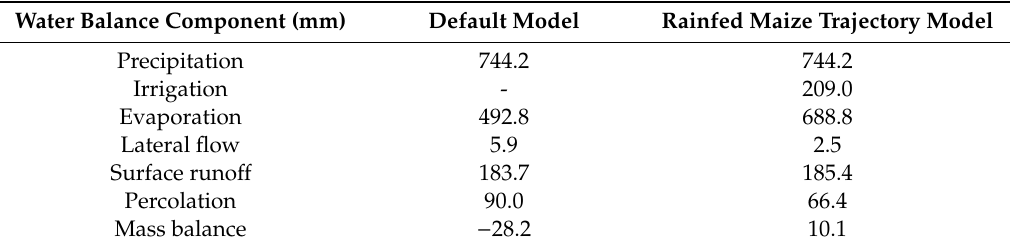
Table 8. Comparison of the water-balance components in SWAT, at the HRU level.